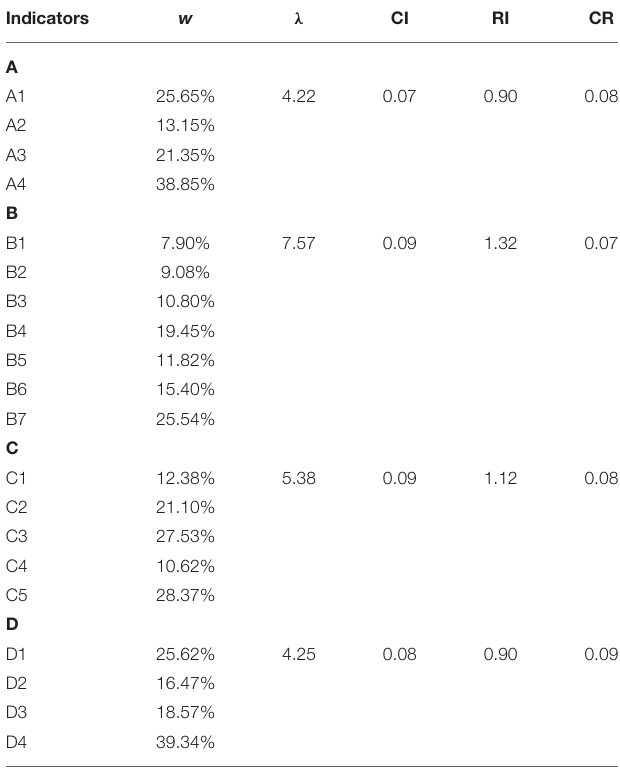
TABLE 6 | The weight coefficients of the second-grade indicators.